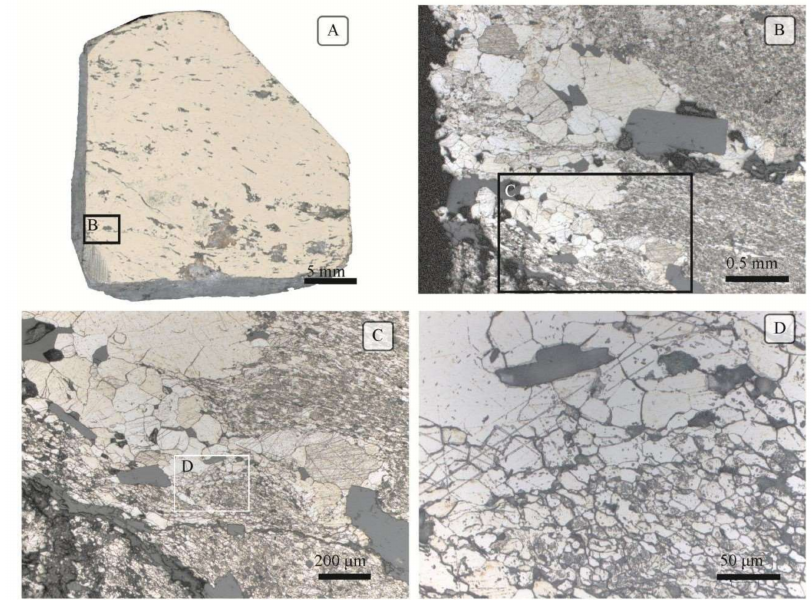
Figure A1. Massive pyrite ore, polished section, reflected light microscopy, sample H1-38,9: ( A ) Massive sulfide ore image; ( B – D ) relicts of primary pyrite crystals and their relationship with silicate minerals and fine-grained pyrite. Please note that fine-grained mass bears traces of metamorphic cleavage.